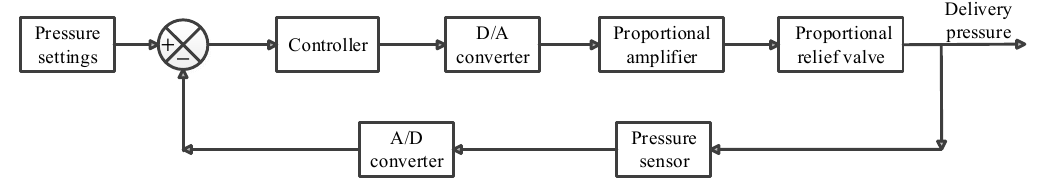
Figure 2. Control schematic diagram.